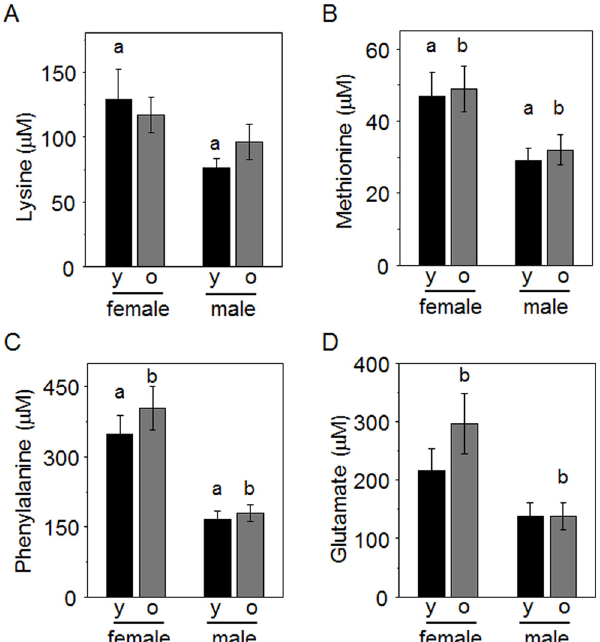
Fig 3. Metabolites higher in female than male marmosets. Female and male marmosets were grouped according to age as younger (y, 2 to 7 y) and older (o, 8 to 15 y). Following ANOVA, post-hoc tests showed differences between groups as indicated by a, female versus male in younger marmosets; b, female versus male in older marmosets. Group sizes were: females, 12 y, 12 o: males 13 y, 13 o.